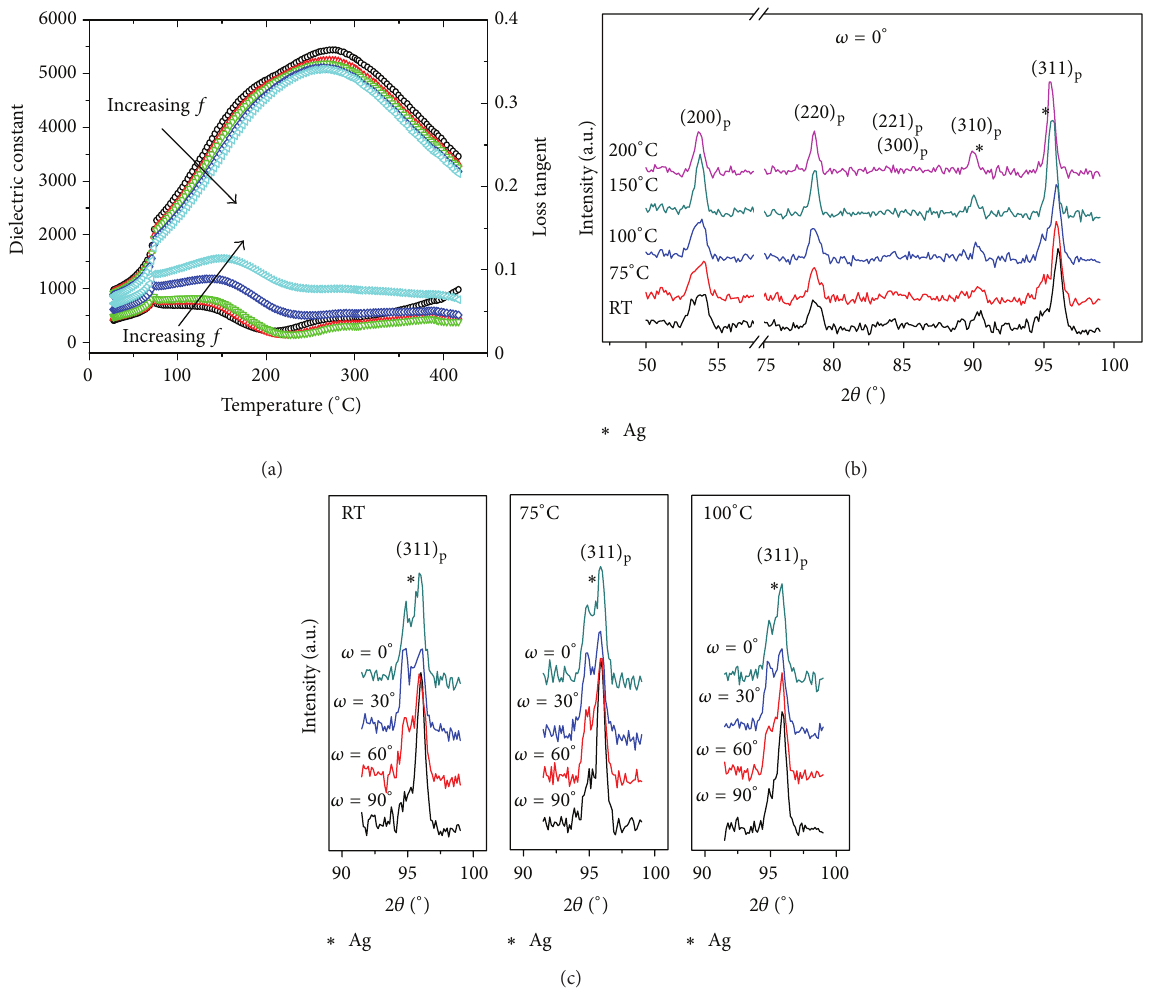
Figure 2: (a) Temperature dependence on dielectric spectra of BNTBT7 ceramic and (b) its neutron diffraction patterns at 𝜔 = 0 ∘ as well as diffraction peak at different temperatures and different 𝜔 (c) a typical (311) p